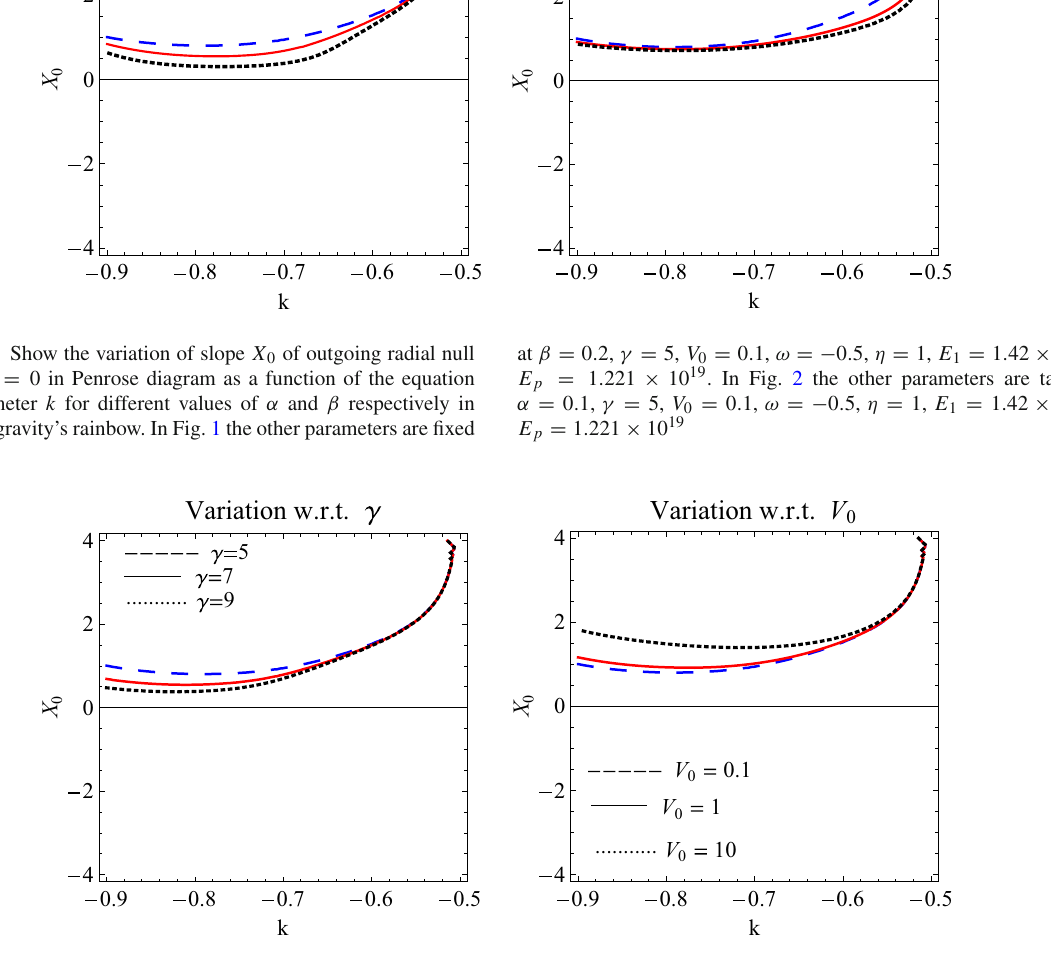
at α = 0 . 1 ,β = 0 . 2, V 0 = 0 . 1, ω = − 0 . 5, η = 1, E 1 = 1 . 42 × 10 − 13 , E p = 1 . 221 × 10 19 . In Fig. 4 the other parameters are taken as α = 0 . 1 ,β = 0 . 2, γ = 5, ω = − 0 . 5, η = 1, E = 1 . 42 × 10 − 13 , 1 E p = 1 . 221 × 10